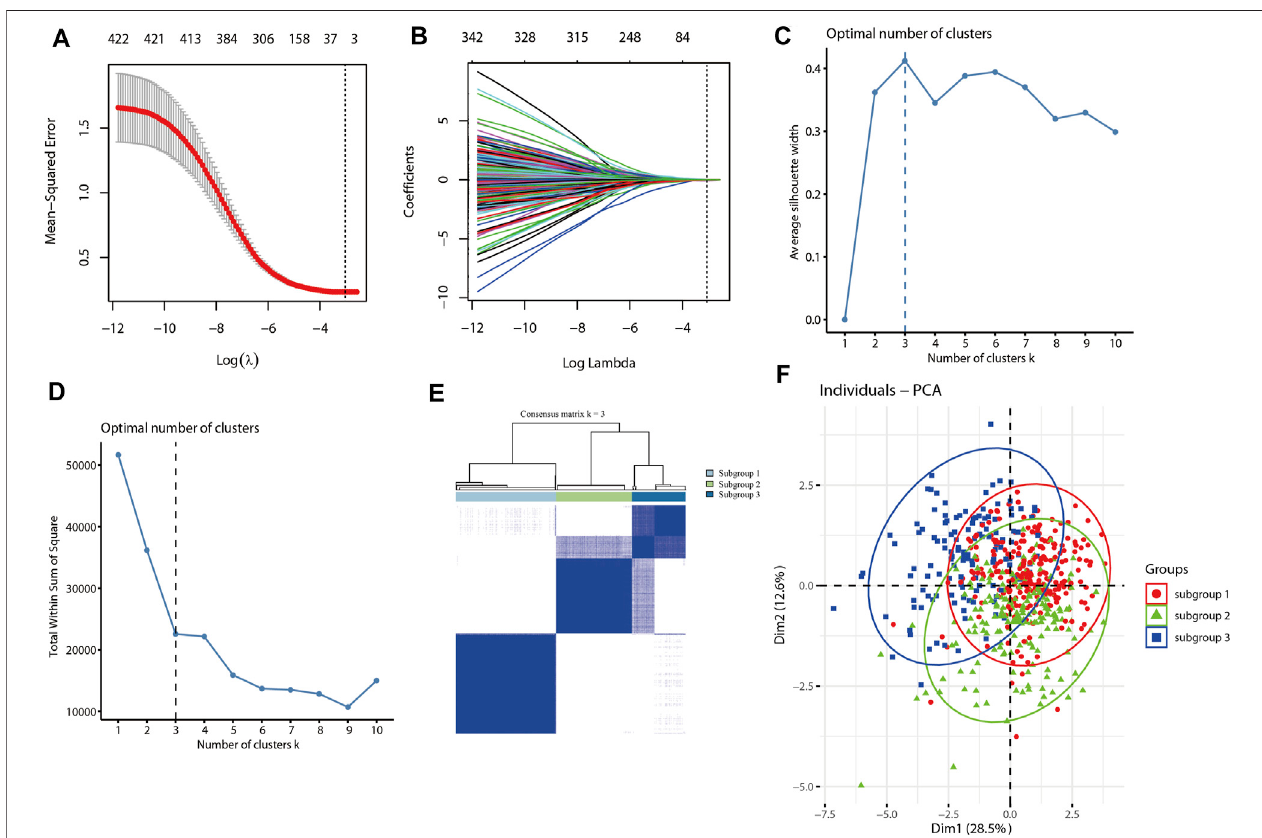
FIGURE 2 | Immune associated subgroup clustering of LUAD by using the LASSO and K-means algorithm. (A) LASSO regression model with 10-cross validation was used to select the optimal λ (dash line) which have the minimum mean square error (red dots). (B) LASSO coef fi cient pro fi les of the selected subsets of immune associated genes at the optimal λ (grey line) for immune related subgroup clustering of LUAD. (C) The curve of average silhouette width under corresponding cluster number k, and the maximum of average silhouette width was achieved when k (cid:1) 3. (D) The curve of total within sum of squared error curve under corresponding cluster number k, and it reached the “ elbow point ” when k (cid:1) 3. (E) The consensus clustering of immune related subgroup of LUAD when k (cid:1) 3. (F) The PCA plot of clustered samples in the LUAD, where samples in subgroup-1 ( n (cid:1) 252) are shown in red, subgroup-2 ( n (cid:1) 188) in green and subgroup-3 ( n (cid:1) 132) in